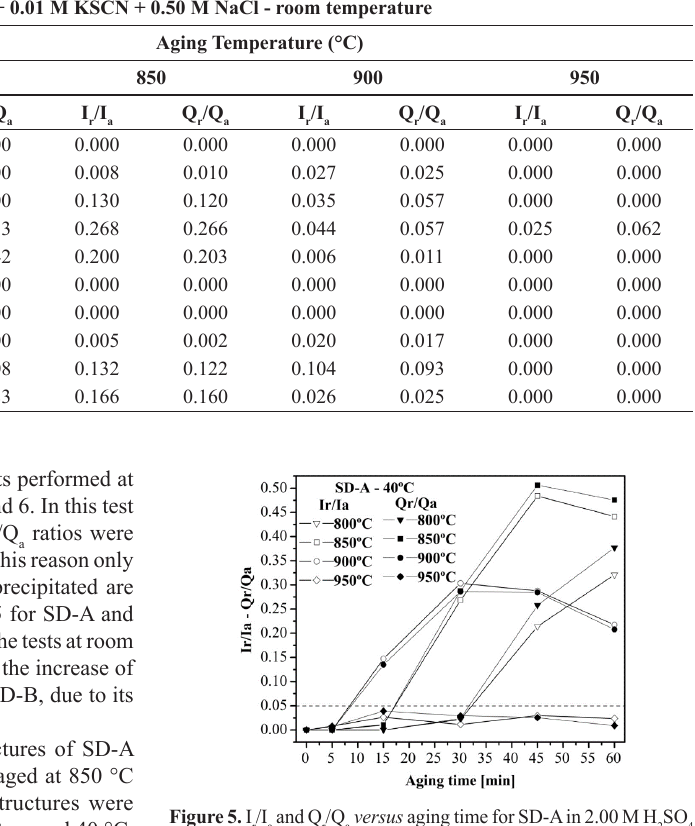
Table 3. I /I and Q /Q values obtained for SD-A and SD-B in 2.00 M H r a r a temperature.